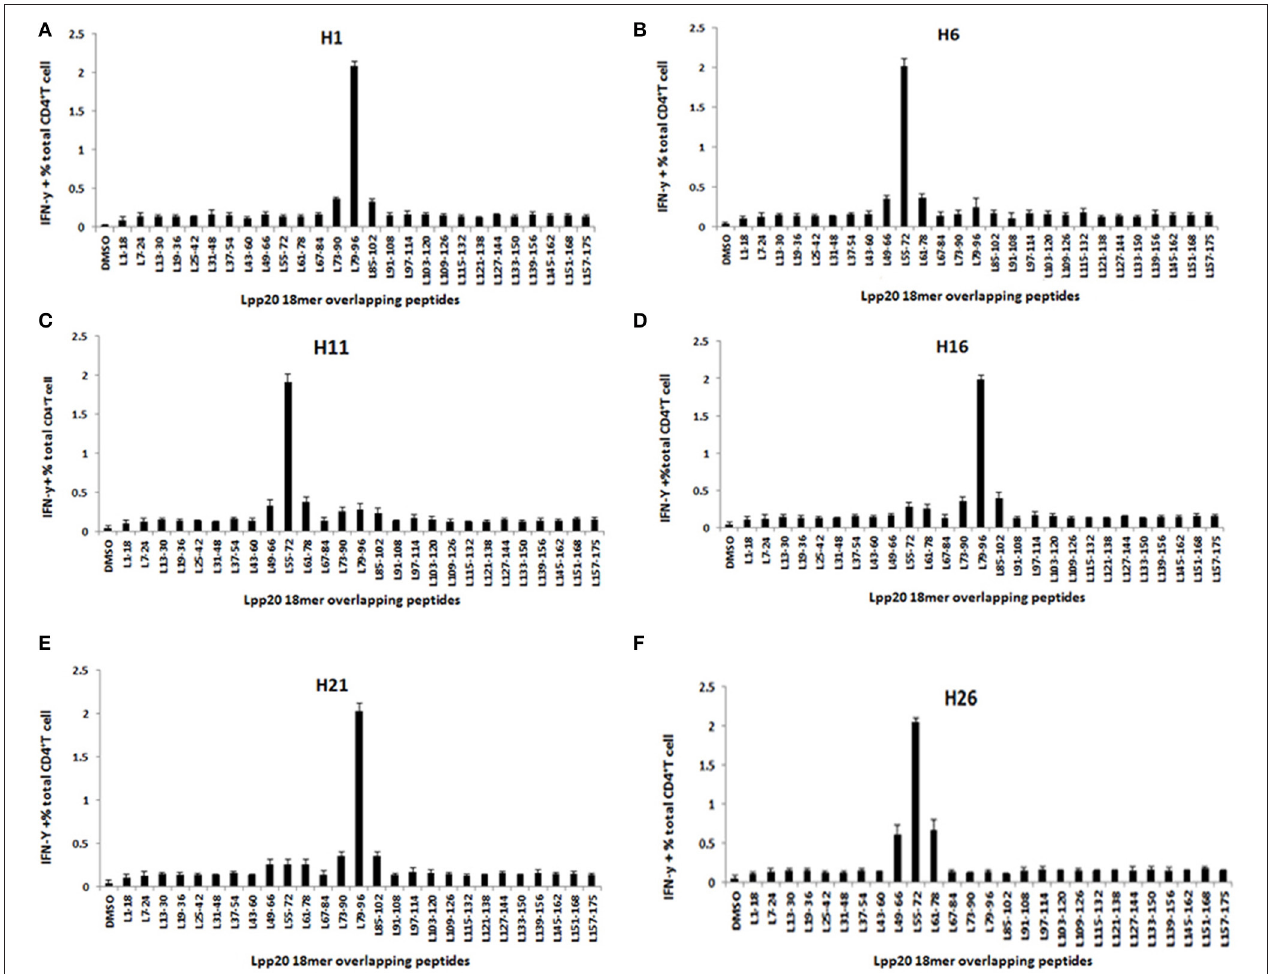
FIGURE 3 | The mapping and identification of the immunodominant Lpp20 CD4 + T cell epitope. Lpp20-specific T cells from H. pylori -infected subject were expanded in vitro as described above and further screened for their specific response to the 27 Lpp20 18mer overlapping peptides at a final concentration of 5 µ mol/L in an ICS assay. The identified 18mer sequences are shown (A–F) correspond to subjects H1, H6, H11, H16, H21, and H26,